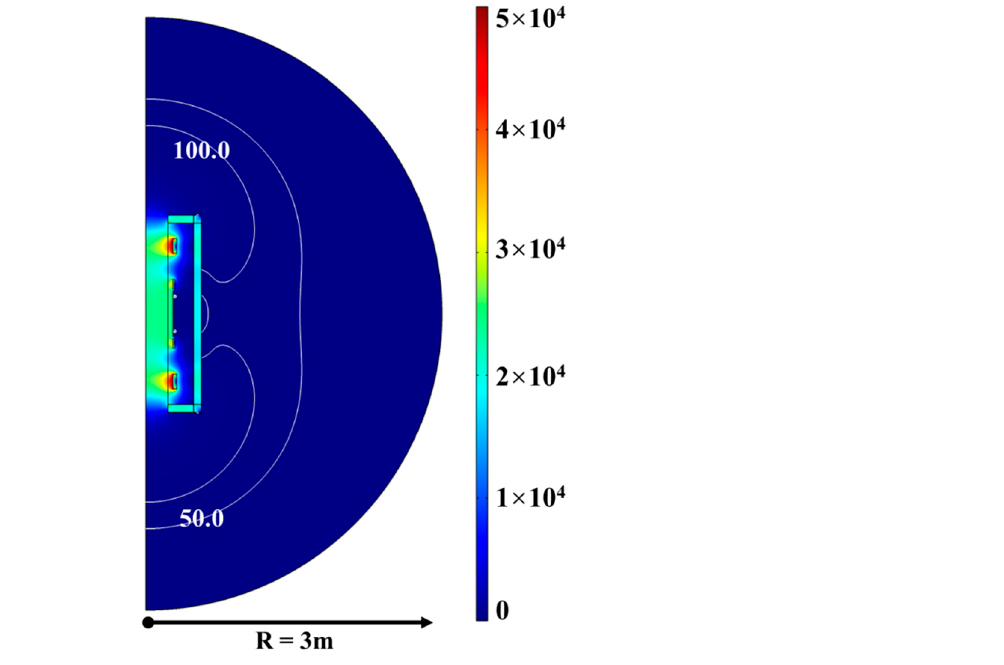
Figure 11. Distribution of the stray magnetic field within 3 m radius from the magnet, with 100 Gausses of the stray field at 1.9 m and 50 Gausses of the stray field at 2.3 m.